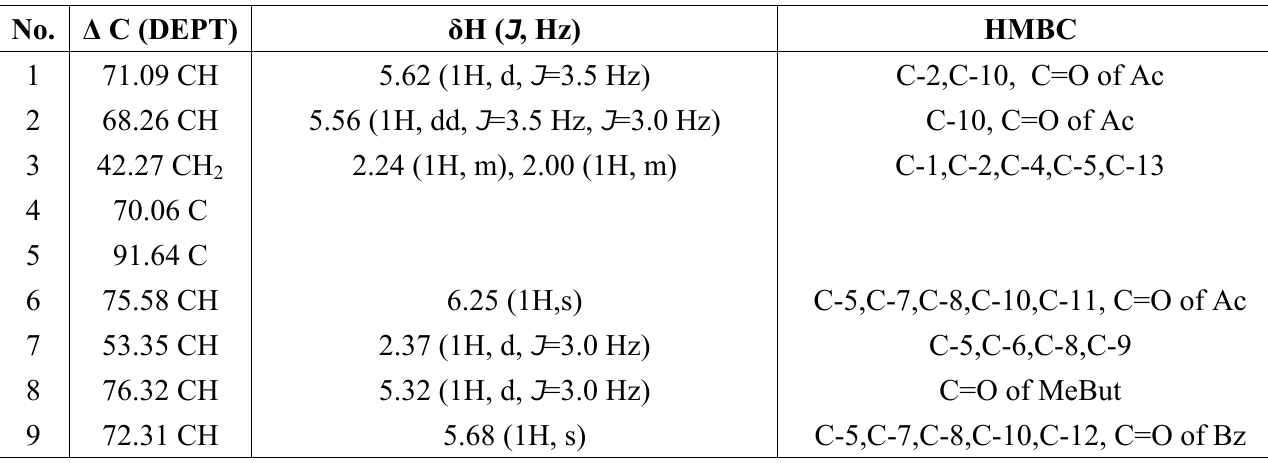
Table 1 . The NMR data of compound 1 . (CDCl 125MHz,